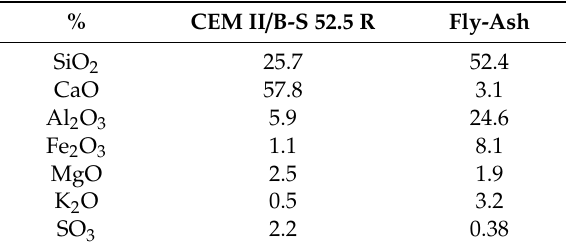
Table 1. Chemical composition of the binder.